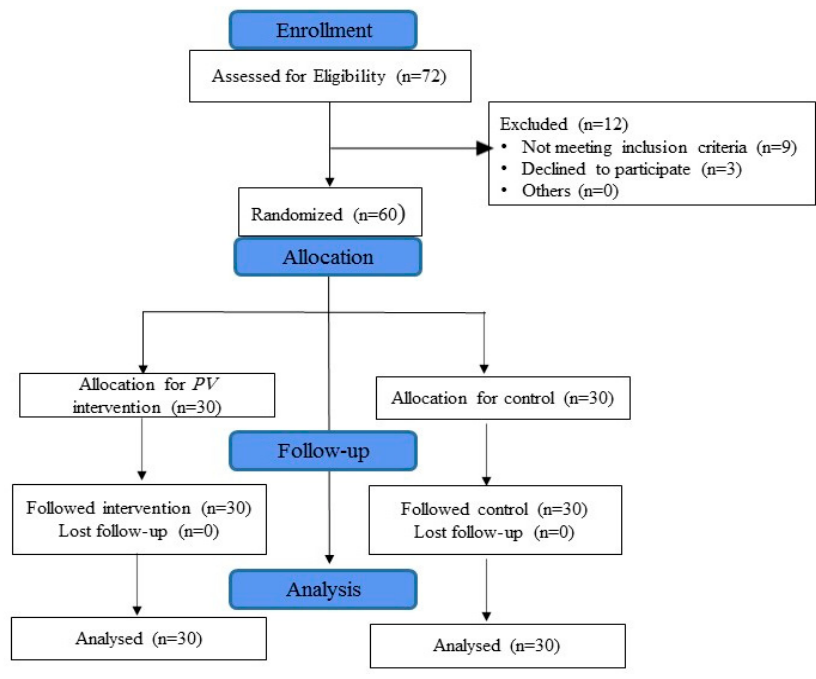
Figure 1. CONSORT flow diagram.